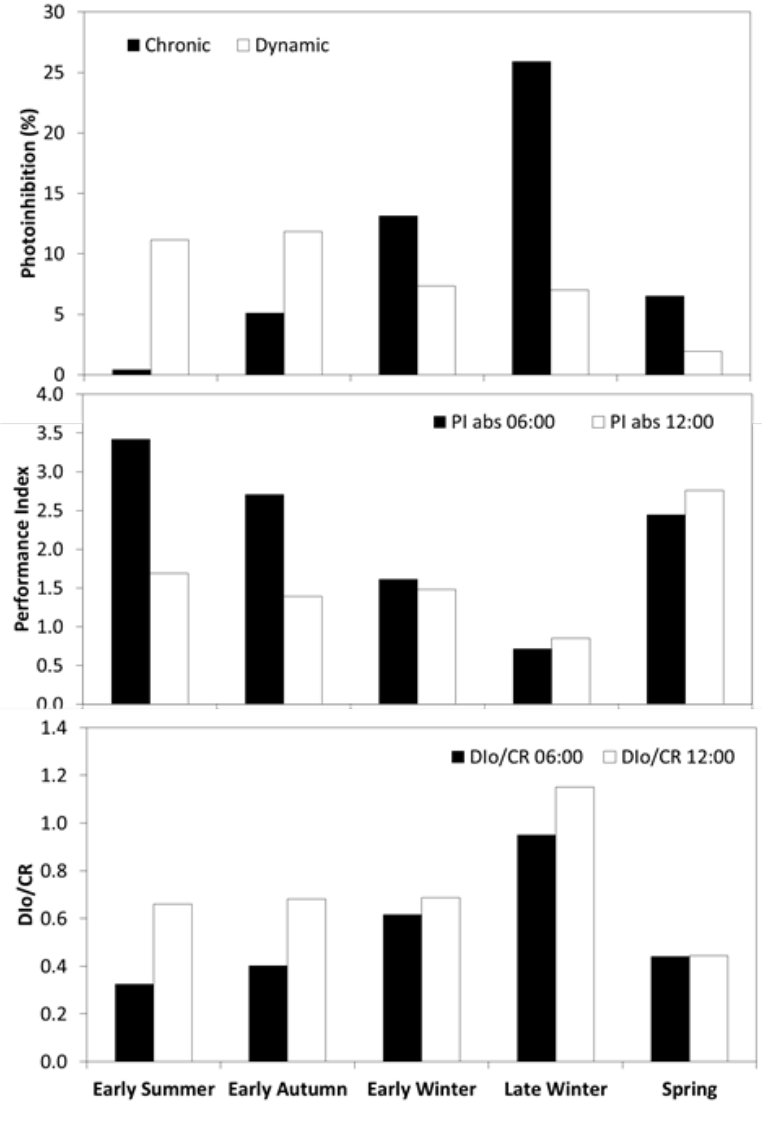
Figure 6. Top: Chronic (black columns) and dynamic photoinhibition (white columns) in percentage during representative days for the seasons. Medium: Performance index (PI abs) at predawn (06:00; black) and midday (12:00: white) on the same days represented on top figure. Bottom: Flux to energy dissipation per reaction center (DIo/CR) at predawn (06:00; black) and midday (12:00; white).